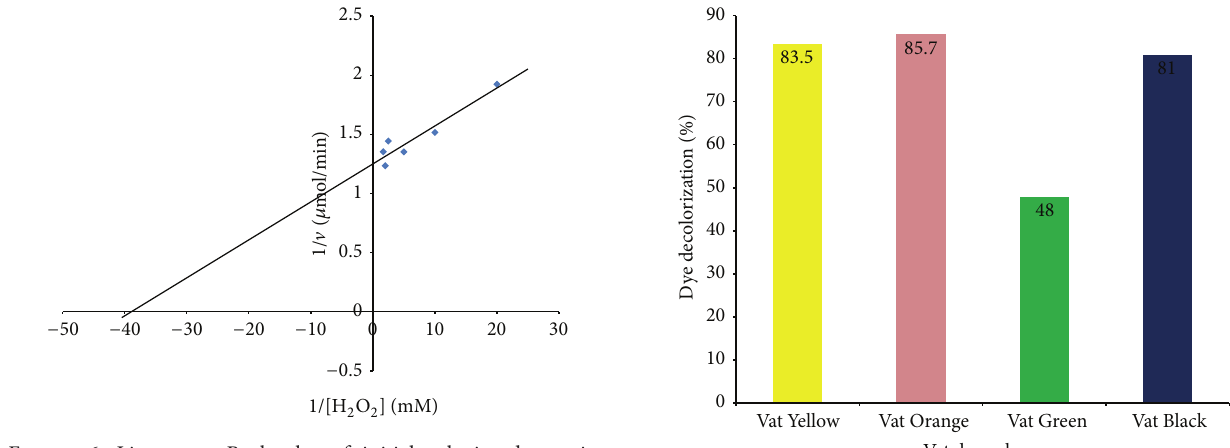
Figure 6: Lineweaver-Burk plot of initial velocity data using different concentration of H 2 O 2 as substrate.